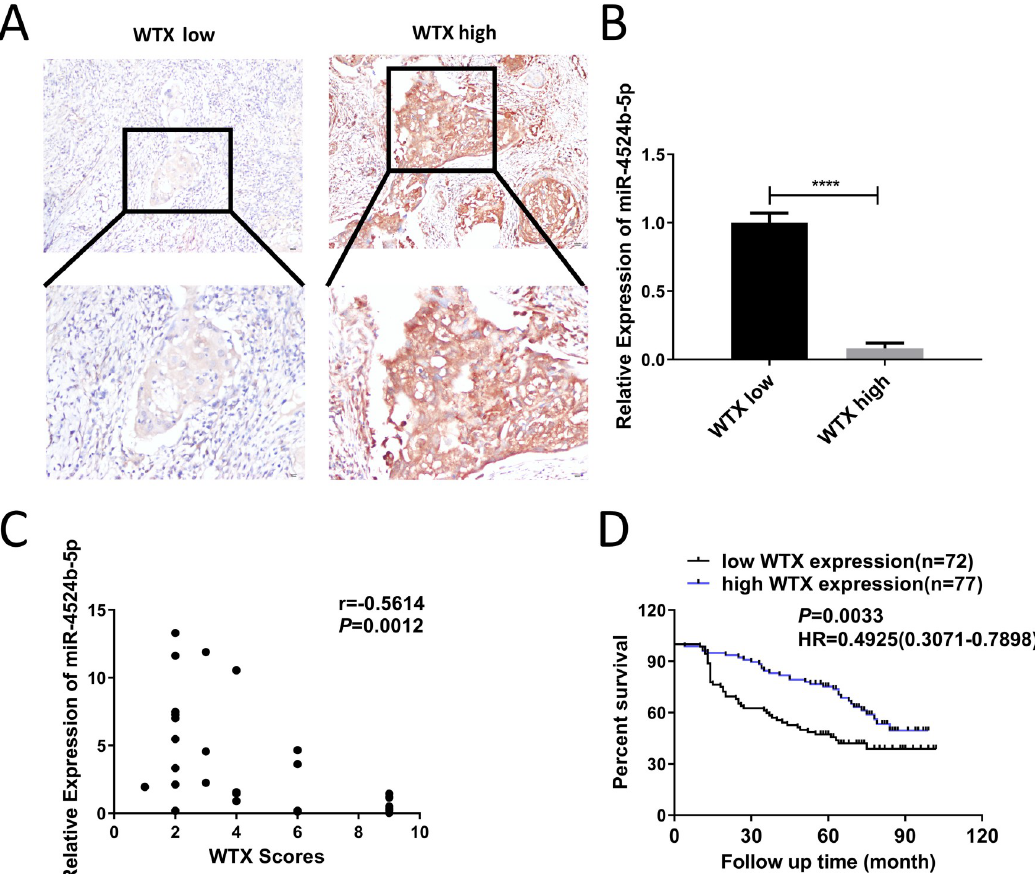
Fig 8. Elevated expression of WTX is linked to the improved overall survival of cervical cancer patients. (A) Representative images of IHC staining for WTX expression in cervical cancer patients. (B) qRT-PCR detected the miR-4524b-5p expression in the same cervical cancer patients. (C) The staining score of WTX was inversely correlated with miR-4524b-5p levels in the 30 cervical cancer tissue samples. (Spearman’s correlation analysis, r = -0.5614, p = 0.0012). (D) Kaplan-Meier overall survival curves for cervical patients with high or low WTX expression. All data are presented as the means ± SEM, ���� P < 0.0001.